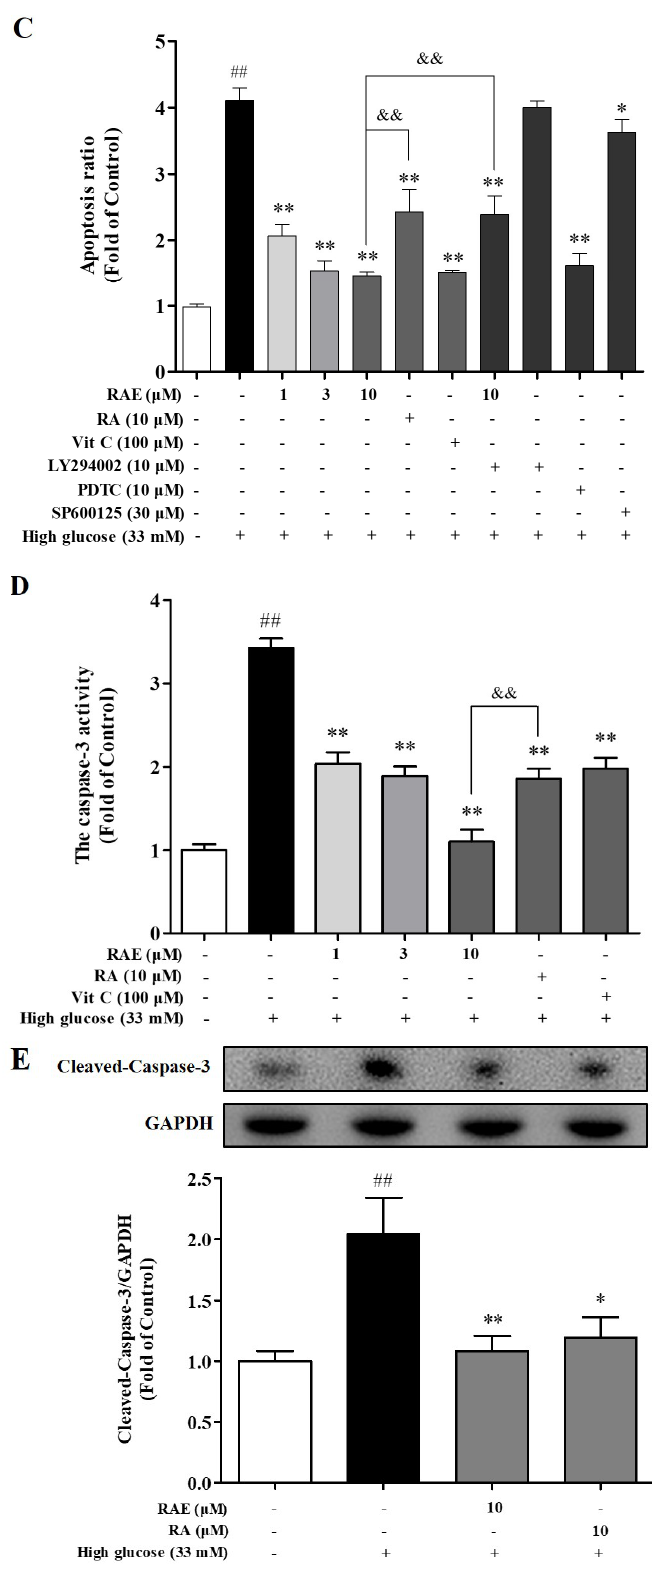
Figure 3. Effect of RAE on apoptosis in human endothelial cells treated with high glucose. EA.hy926 were treated with RAE or RA at indicated concentrations in the medium containing 33 mM of glucose for 48 h. (I) Control; (II) High-glucose model group; (III) RAE 1 µ M; (IV) RAE 3 µ M; (V) RAE 10 µ